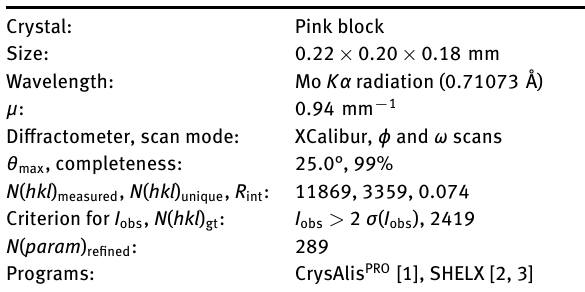
Table 2: Fractional atomic coordinates and isotropic or equivalent isotropic displacement parameters (Å 2